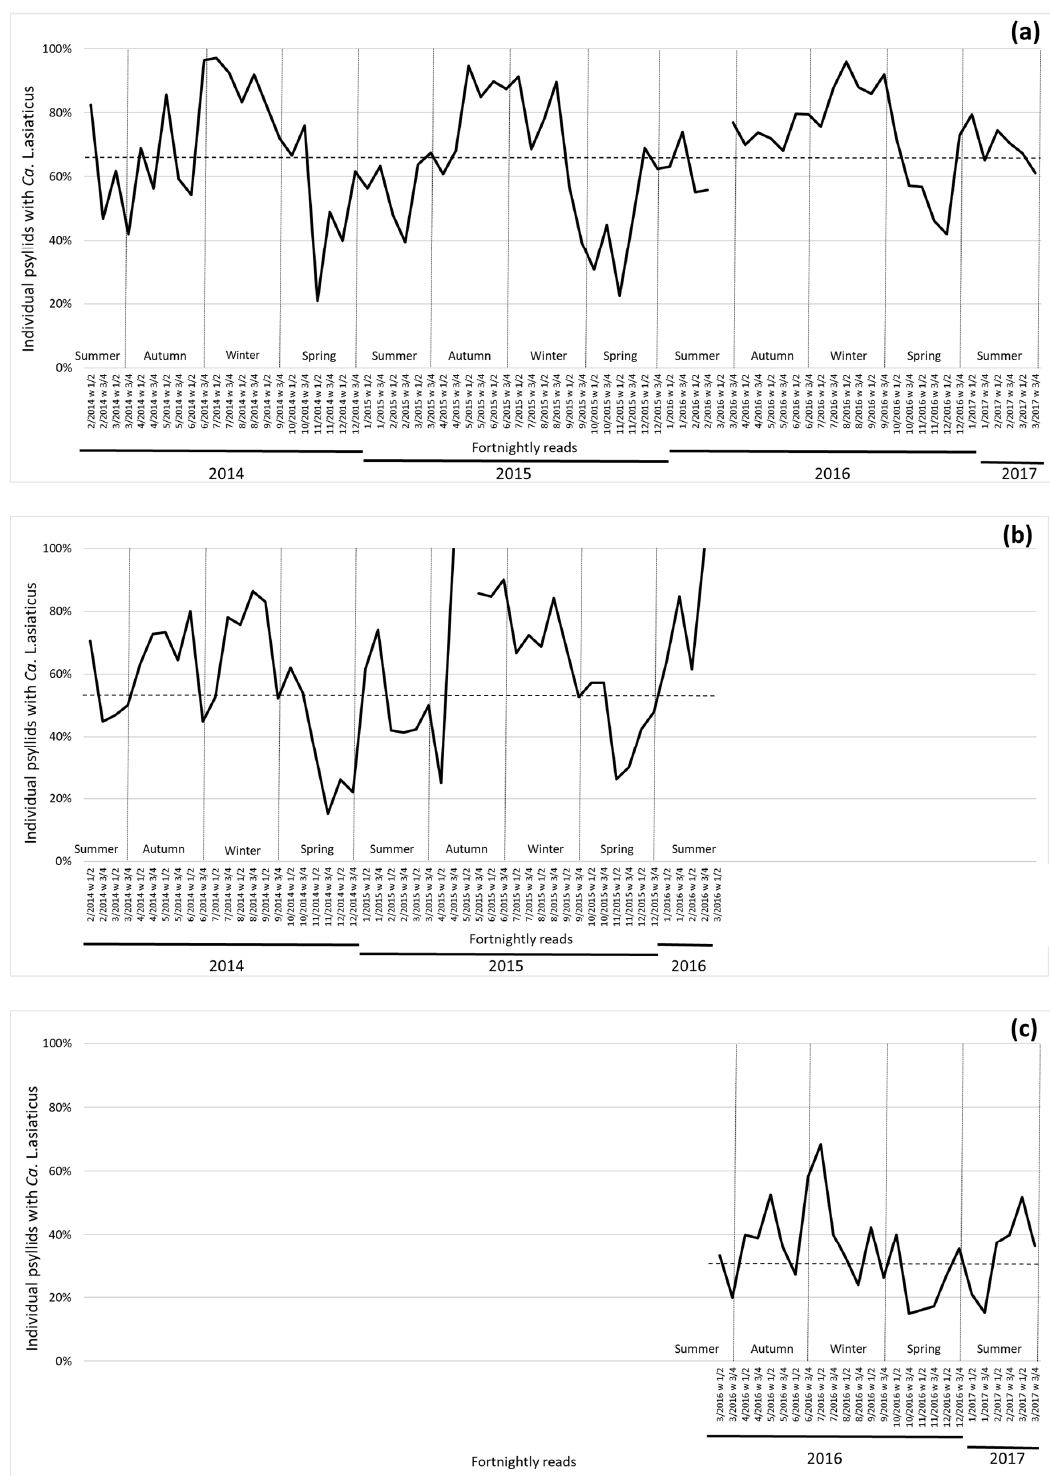
Figure 3. Percentage of psyllids carrying Candidatus Liberibacter asiaticus in fortnightly reads between February 2014 to March 2017. Dotted line indicates average for the region (each time point is indicated with month / year numbering and week interval). Season indication was added to the image according to standard occurrence in the southern hemisphere. ( a ) Central region (Araraquara; 1 time point missing); ( b ) northern region (Bebedouro; data up to February of 2016; one time point missing), and ( c ) northern region of S ã o Paulo / southwestern region of Minas Gerais states (Frutal; data starts March of